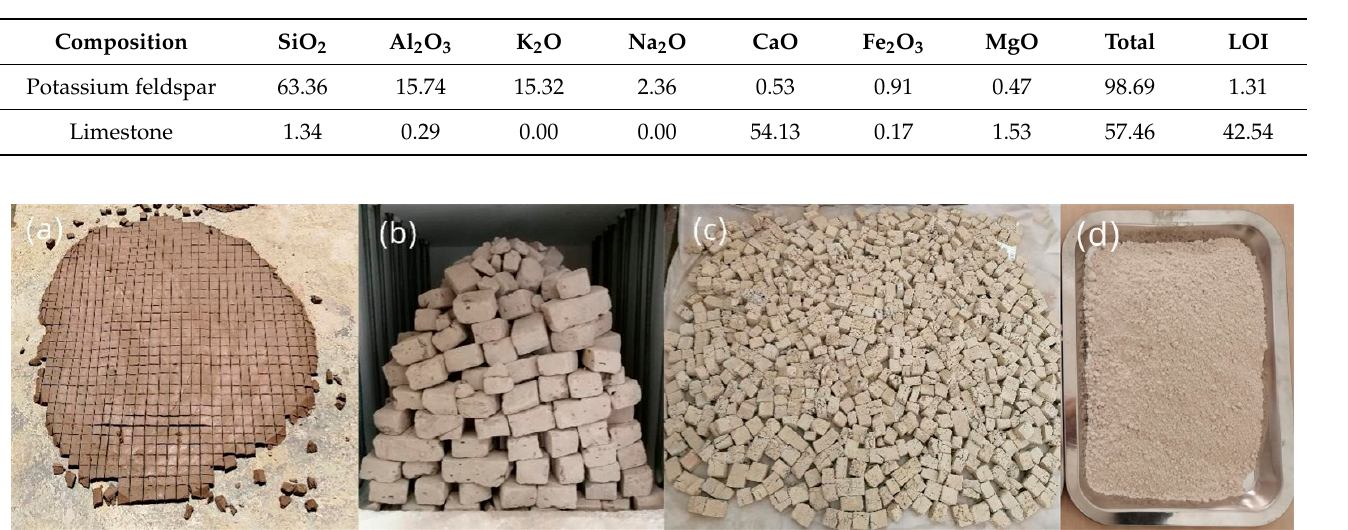
Table 1. Chemical compositions of potassium feldspar and limestone (Mass/%).